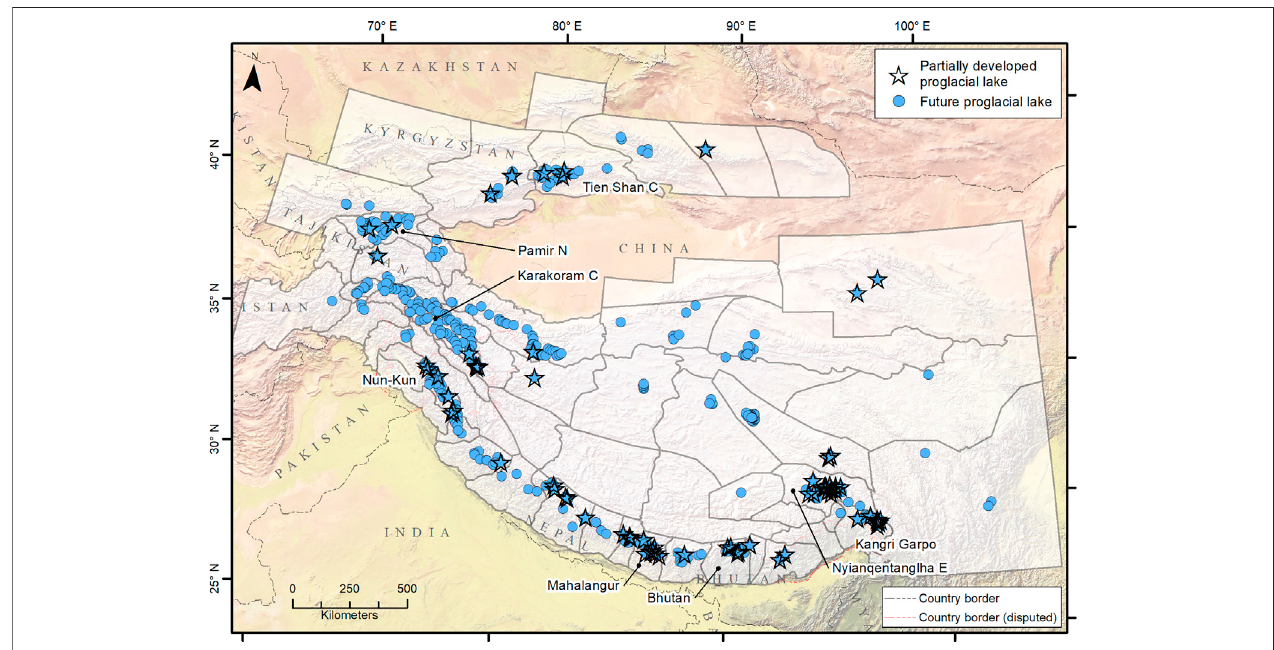
FIGURE 5 | Future proglacial lakes ( n = 415) in 2100. Stars ( n = 69) indicate locations where modeled proglacial lakes are already forming, according to the comparison of our data with Shugar et al. (2020).